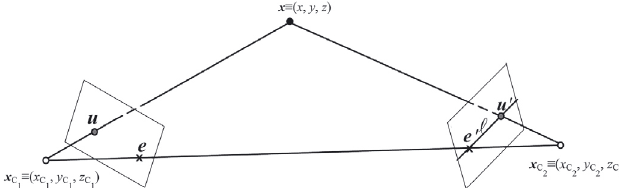
and x C are the 1 2